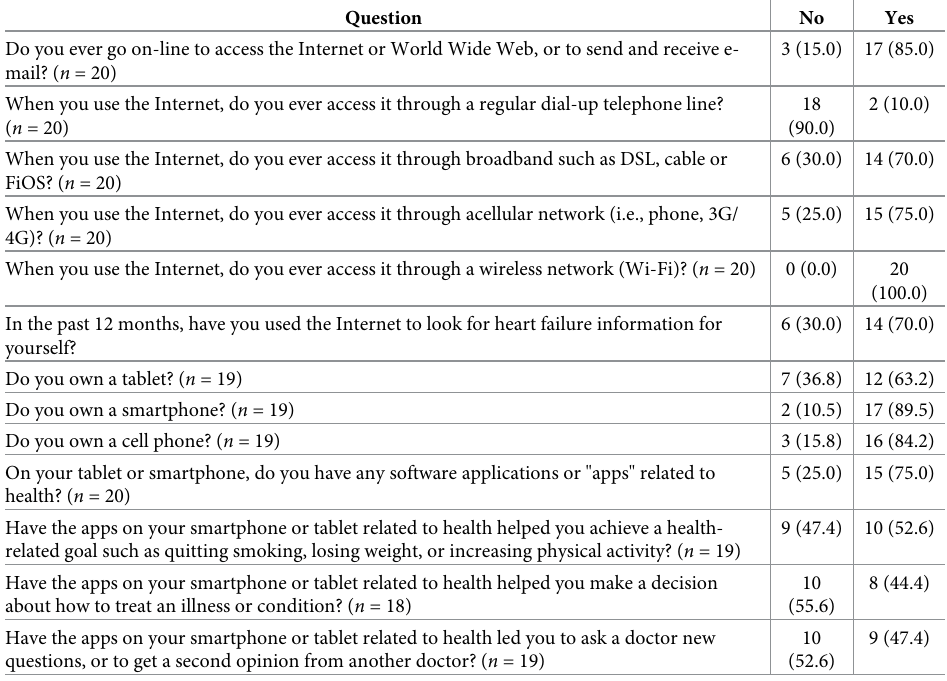
Table 3. Patient answers to the Health Information National Trends